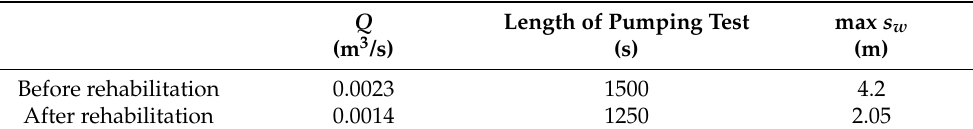
Table 2. Pumping test parameters before and after rehabilitation.